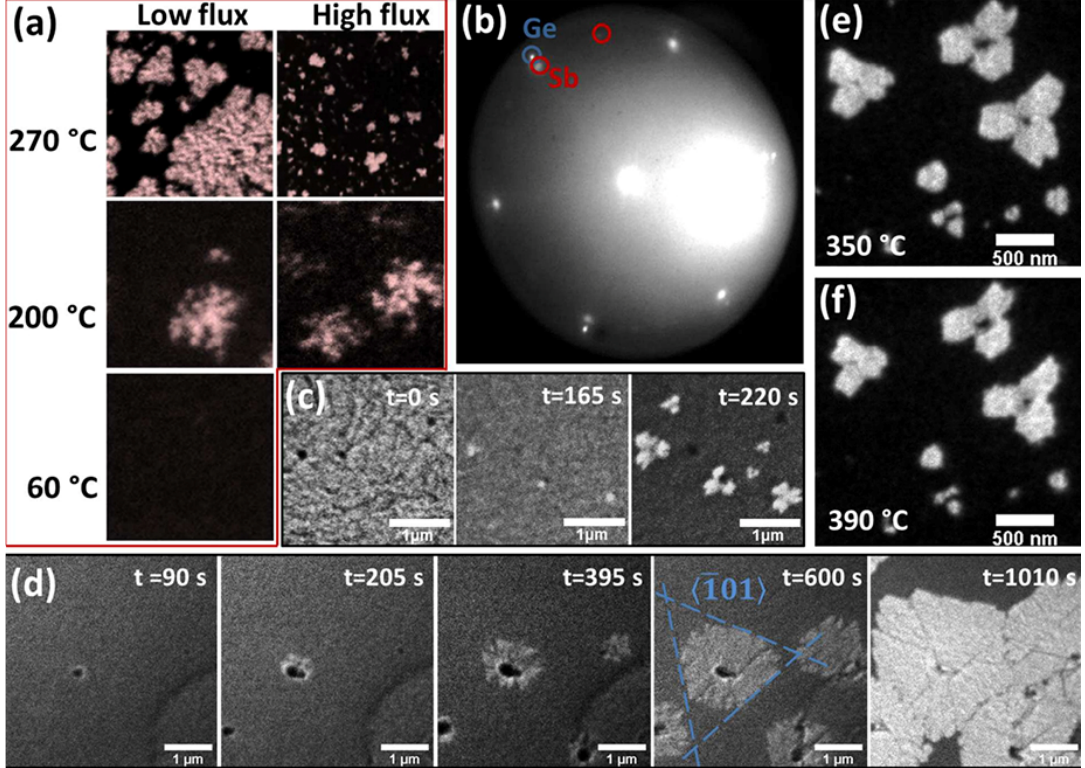
Figure 10. In situ LEEM /LEED observation of 2D Sb growth: ( a ) Effects of temperature and deposition rate on 2D Sb growth. In the low − flux zone, the deposition rates for each substrate temperature were F (T = 60 °C) = 2 Å/min, F (T = 200 °C) = 2 Å/min, and F (T = 270 °C) = 50 Å/min. In the high flux area, the deposition rate is F (T = 200 °C) = 10 Å/min, F (T = 270 °C) = 200 Å/min; ( b ) Typical post − growth LEED pattern (16 eV), showing Sb (red) and Ge (blue) spots; ( c , d ) 2D Sb growth snapshot; ( c ) = 280 °C, F = 50 Å/min and; ( d ) T = 325 °C, F = 200 Å/min; ( e , f ) signs of thermal decomposition. Reprinted with permission from Ref. [12]. Copyright 2017, American Chemical Society.